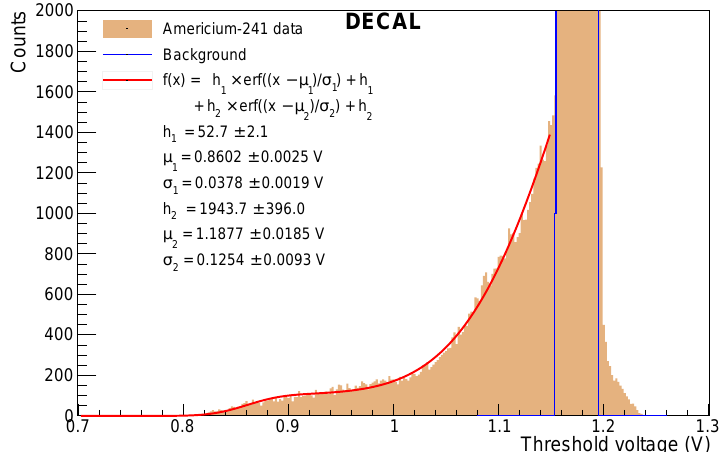
Figure 17. Full data from 241 Am source test. The top plot shows the full histogram from the source test. The lower plot is a zoomed-in view of the signal shoulder on linear scale. The height h i is the multiplicative constant of the corresponding error function and the mean µ i and width σ i its parameters, obtained by the red fit function to the signal shoulder. Background data measured without the Americium source incident on the sensor are indicated by the blue line.